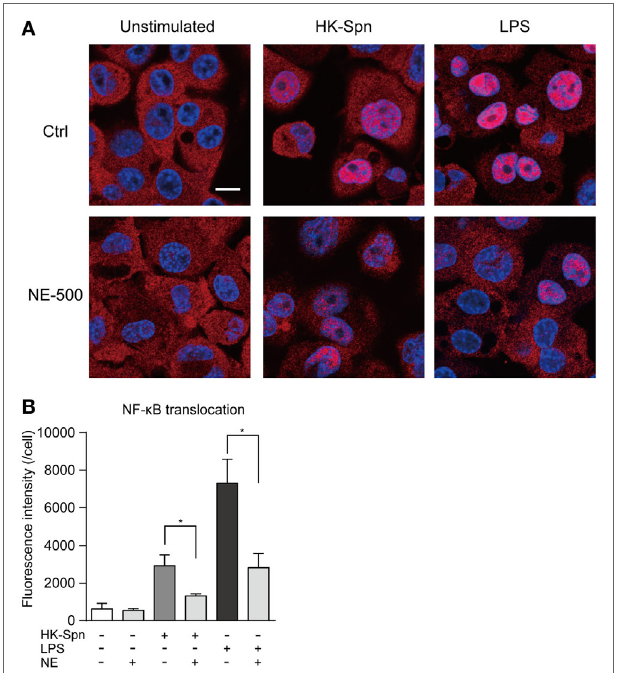
FigUre 2 | Neutrophil elastase (NE) inhibits NF- κ B translocation to the nucleus in macrophages. THP-1-derived macrophages were exposed to hNE (500 mU/mL) in the presence or absence of HK-Spn or LPS (100 ng/mL) for 30 min. (a) Representative fluorescence microscopy images of macrophages stained for DNA (DAPI; blue) and NF- κ B p65 (red). Scale bar: 10 µm. (B) The fluorescence intensity of NF- κ B p65 in the nucleus per cell was calculated. Data represent the mean ± SD of quadruplicate experiments and were evaluated using one-way analysis of variance with Tukey’s multiple- comparisons test. *Significantly different within the same activation status at P < 0.05. HK-Spn, heat-killed S. pneumoniae ; LPS, lipopolysaccharide; hNE, human neutrophil